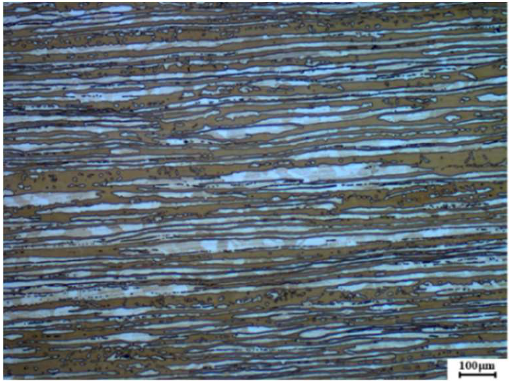
Figure 1. The microstructure of a 2205 duplex stainless steel plate. Table 1. Main chemical composition of DSS2205 and ER2209 (wt.%).